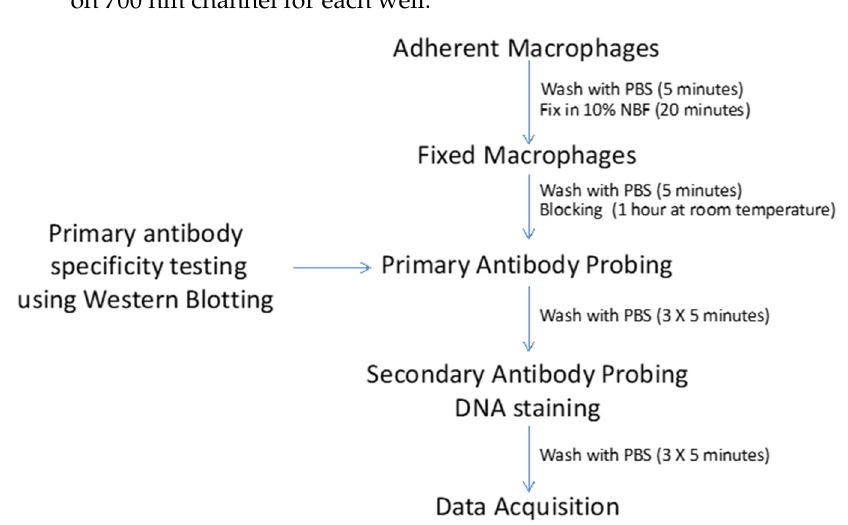
Figure 3. Macrophage Activation Marker Analyses.